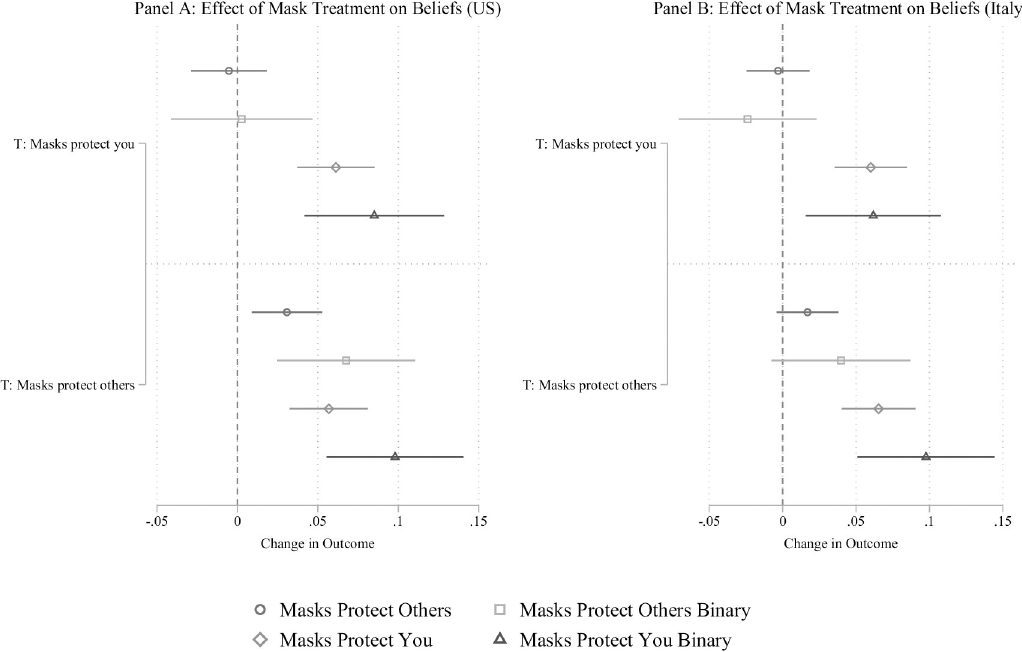
Fig 1. Effect of information on beliefs about masks protecting you and protecting others compared to the control condition. The figure displays OLS regression estimates with 95% confidence intervals. Models included covariates described above. For the binary outcomes, respondents who answered “strongly agree” were coded 1 and those who did not were coded 0.